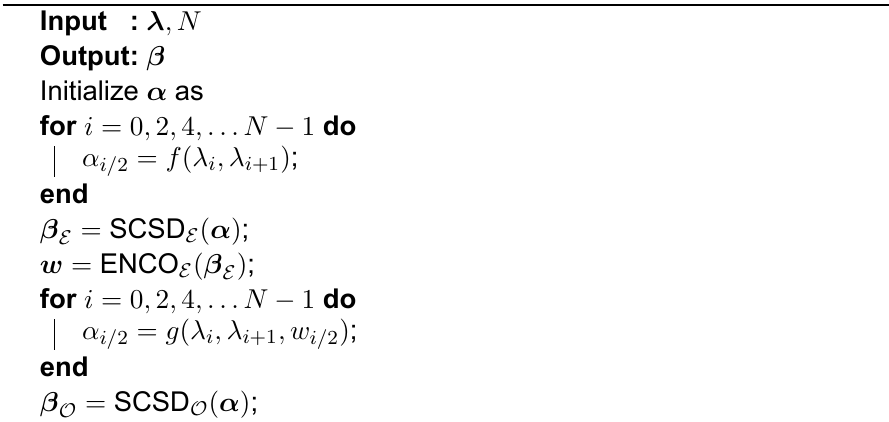
Algorithm 3: Bidirectional stack decoding